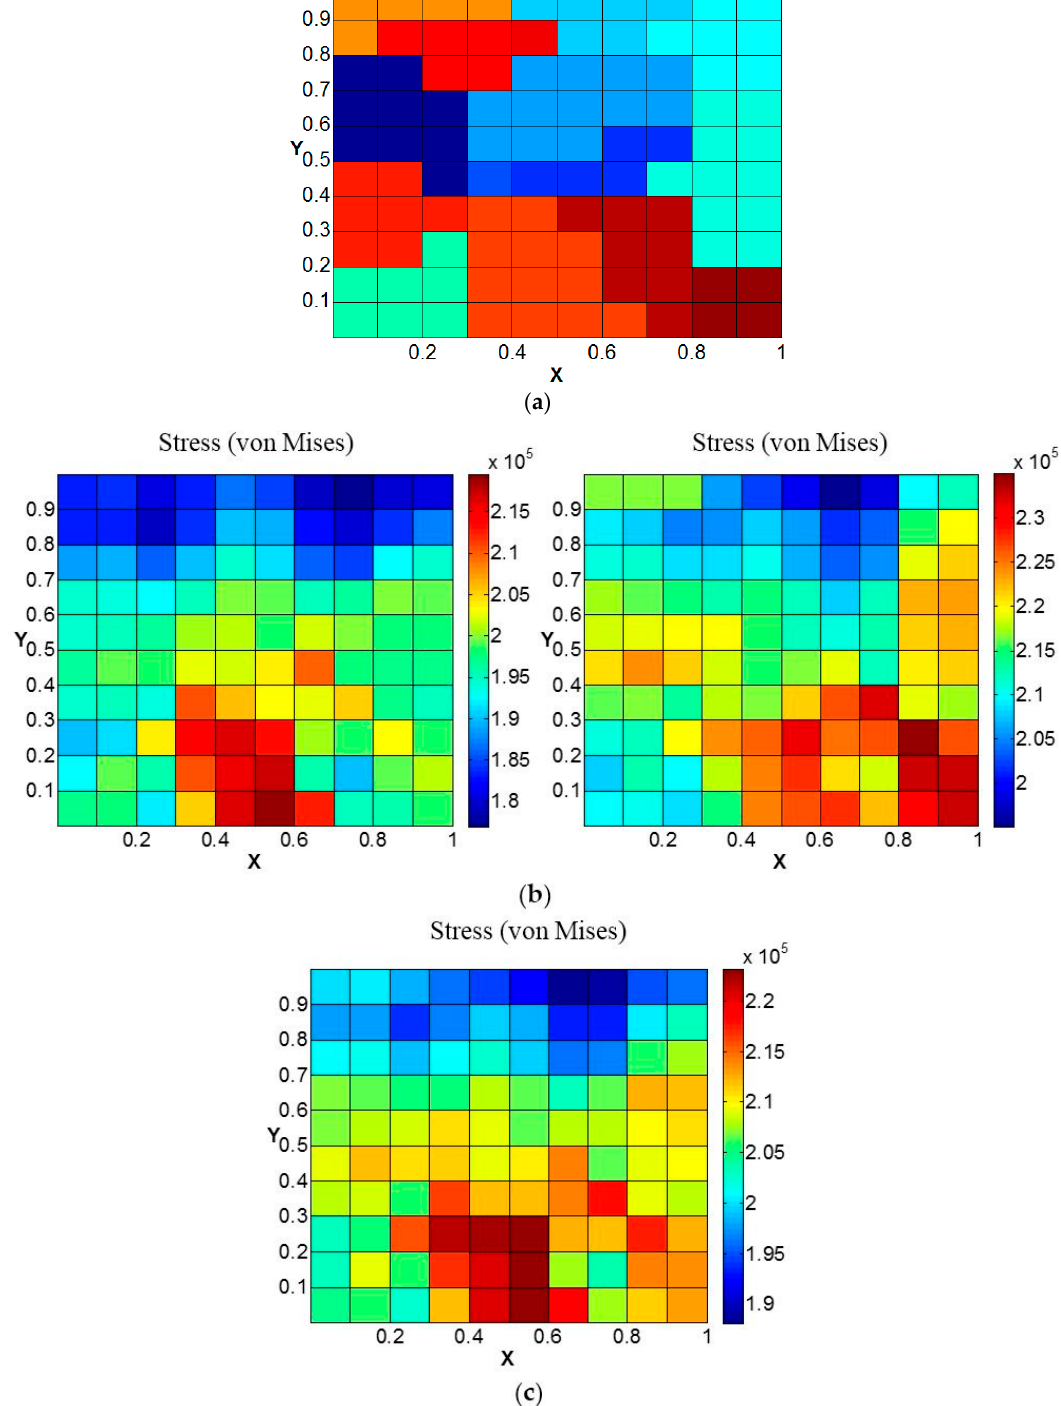
Figure 13. Micro-level study at integration points (for Element 112): ( a ) chosen cross-section; ( b ) von Mises stress in two chosen integration points; ( c ) the average value of von Mises stress over all the integration points of the element.